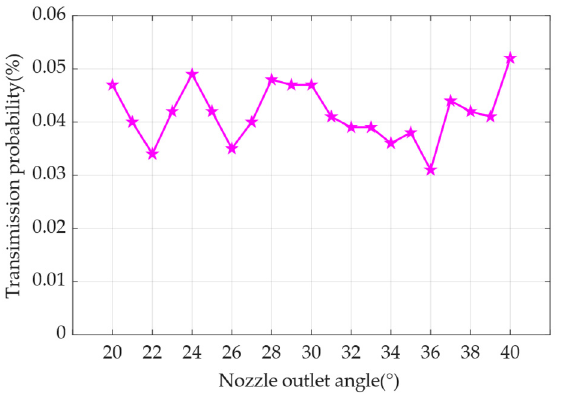
Figure 13. Relationship between nozzle outlet angle and transmission probability. The simulation results are indicated by pentagrams in the line graph. The x-axis represents the nozzle outlet angle, as shown in Figure 2 and Table 1. The y-axis represents the transmission probability, which is the ratio of the number of particles received at the sensor sampling port to the total number of